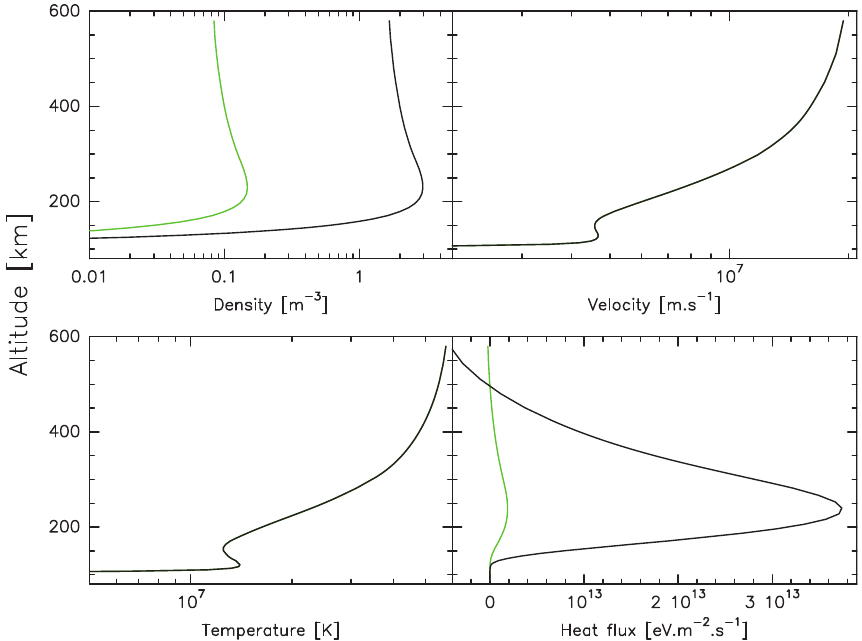
Fig. 11. Electron moments for a total energy E tot = 5 erg (green) and 100 erg (black) and a similar central energy E o = 10